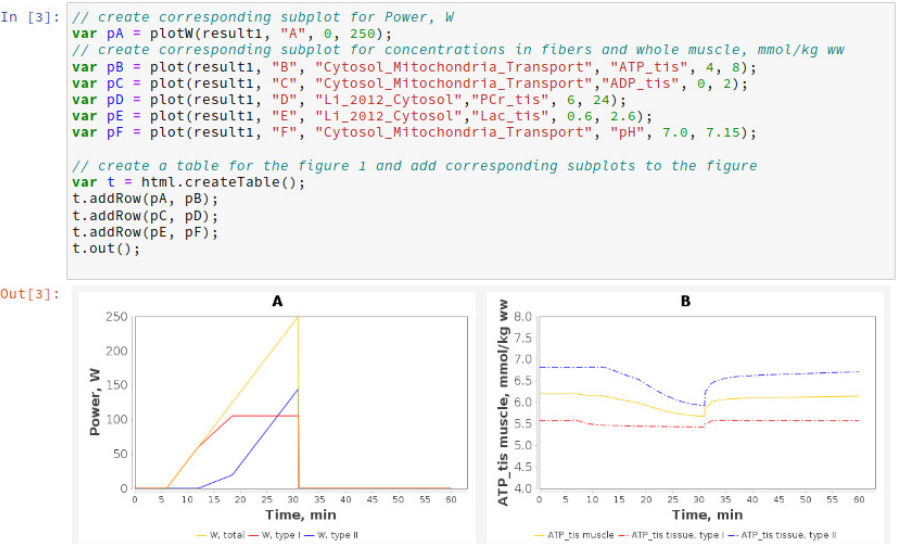
Figure 3. A fragment of Jupyter notebook reproducing the results presented in the current study: ( A ) Exercise power and fiber recruitment pattern: total power (orange), power generated by type I (red) and II (blue) fibers; ( B ) ATP concentration in type I (red, dotted) and II (blue, dotted) fibers and in the muscle tissue (orange, solid) during the incremental ramp exercise until exhaustion.